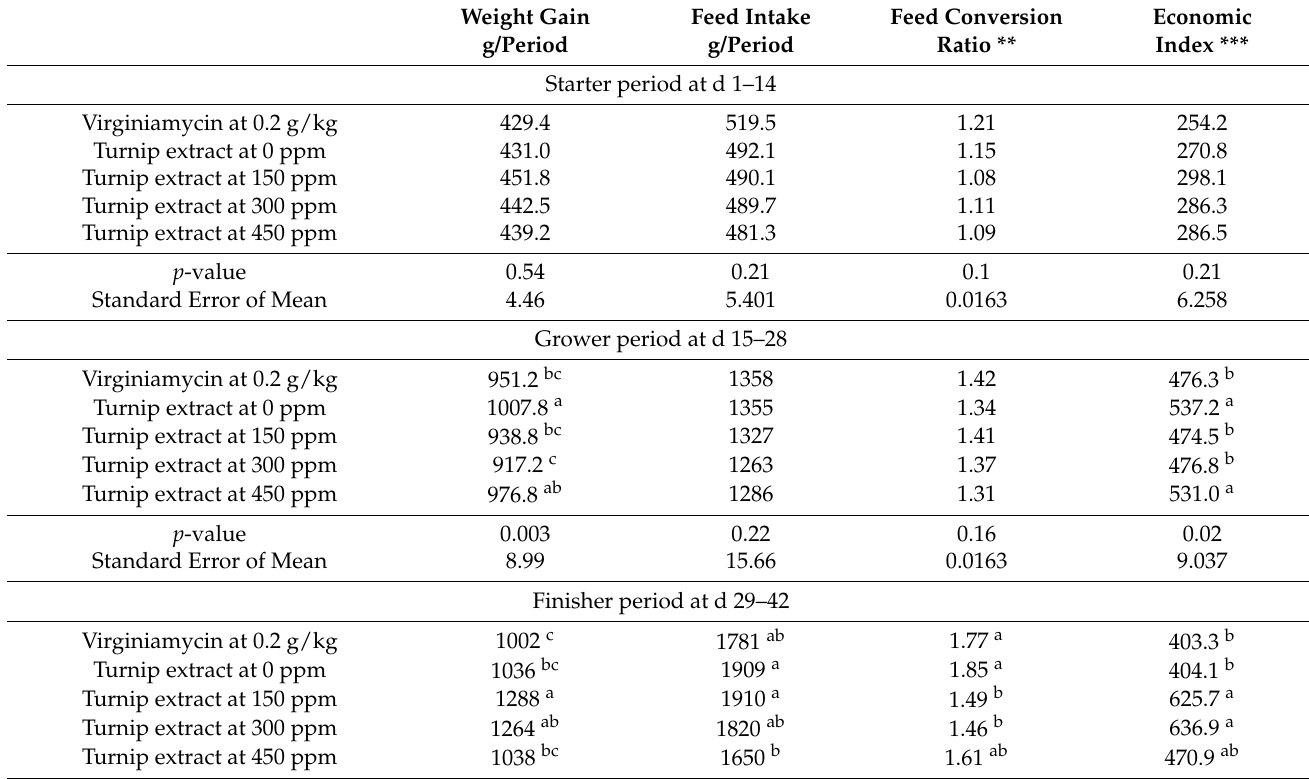
Table 2. Performance means ± SEM of Ross 308 broilers during the starter, grower, finisher and total periods when supplemented with different levels of Brassica rapa extract at 0–450 ppm or Virginiamycin from weeks 1–6